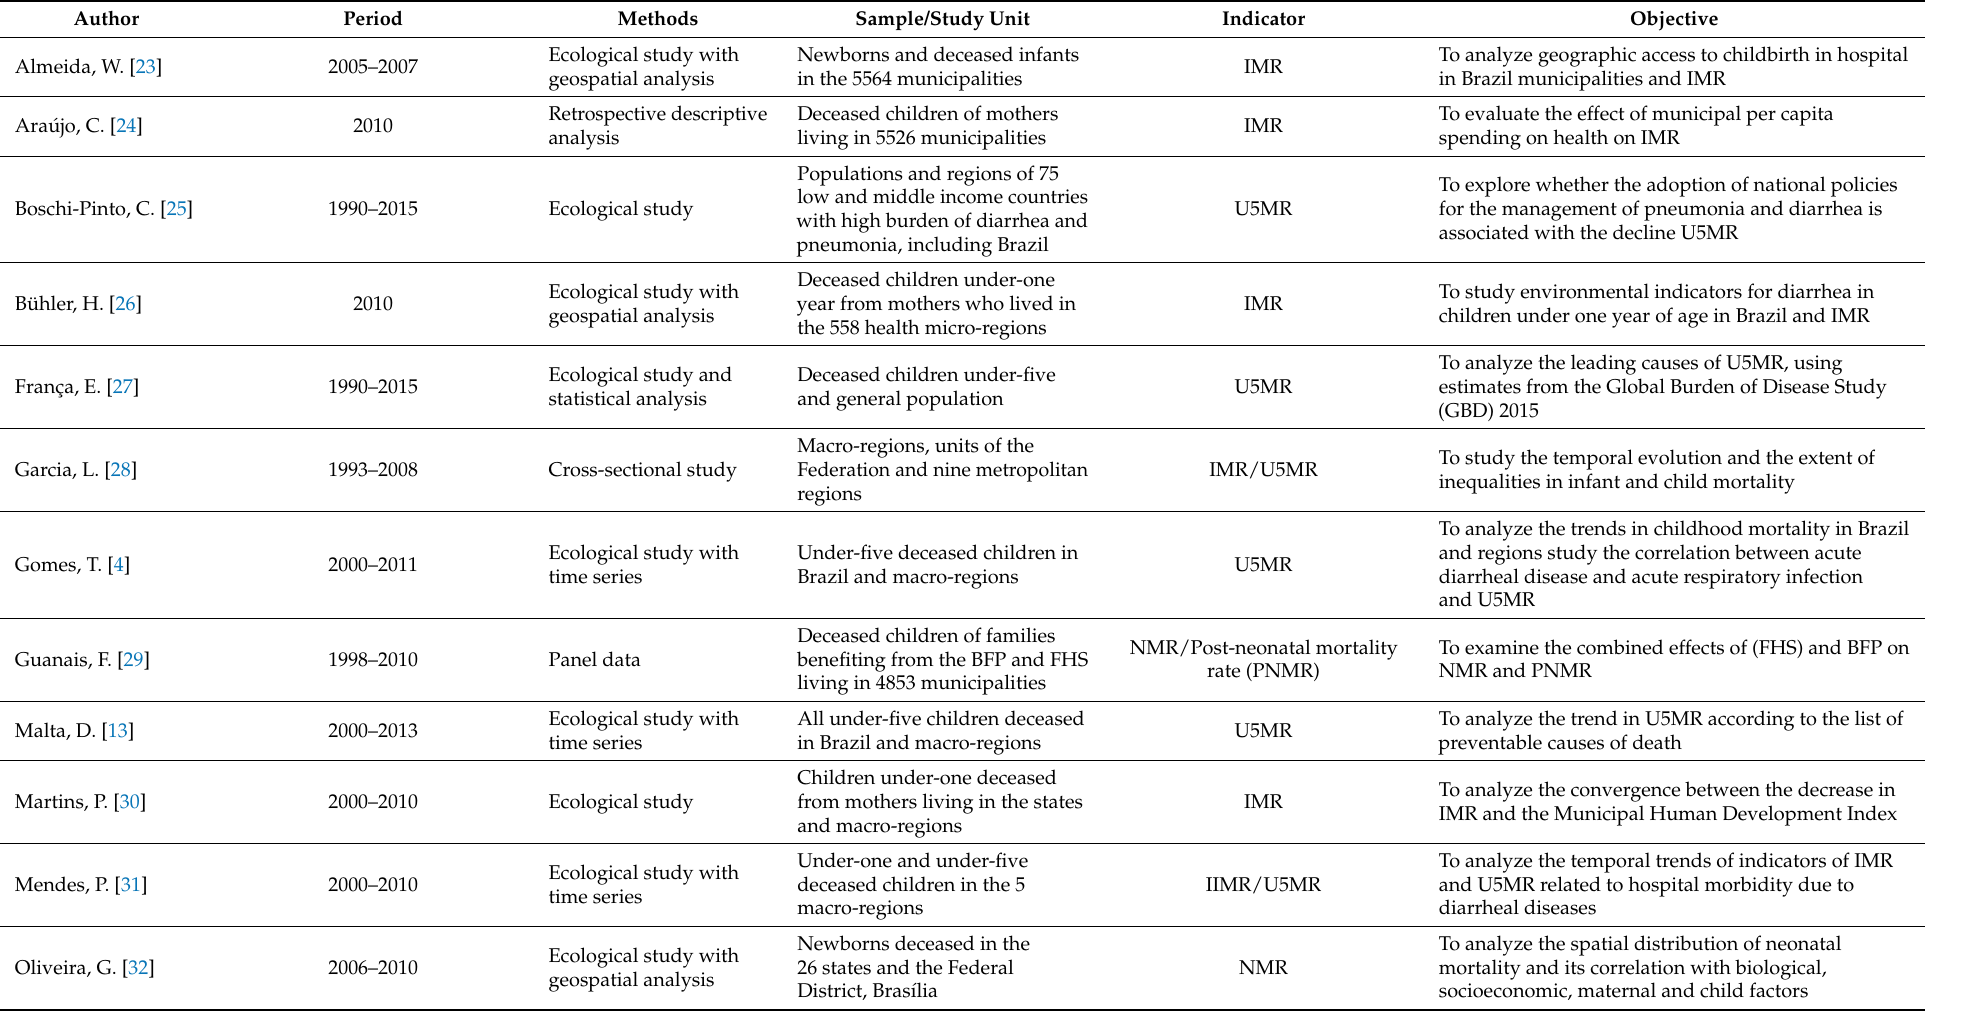
Table 2. Studies included by period, methods, sample/study unit, infant mortality indicator and study